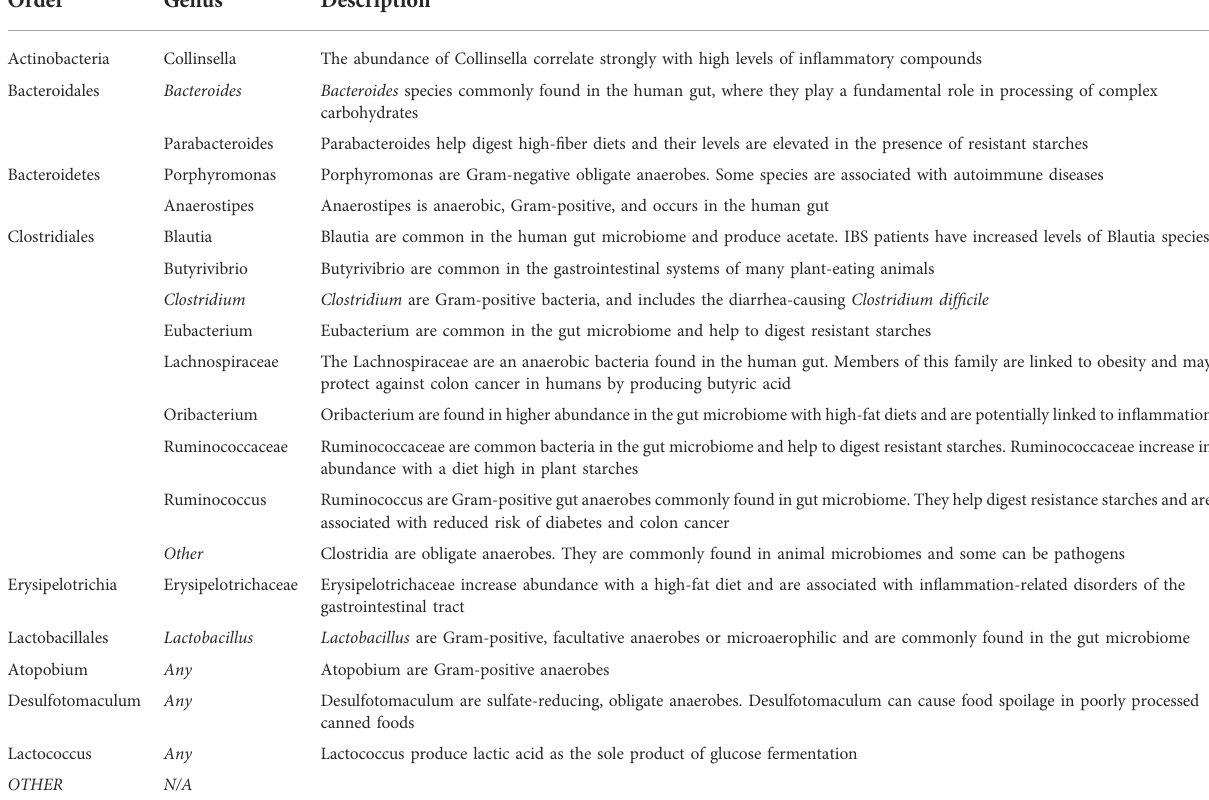
TABLE 1 Taxa used in mouse microbiome community